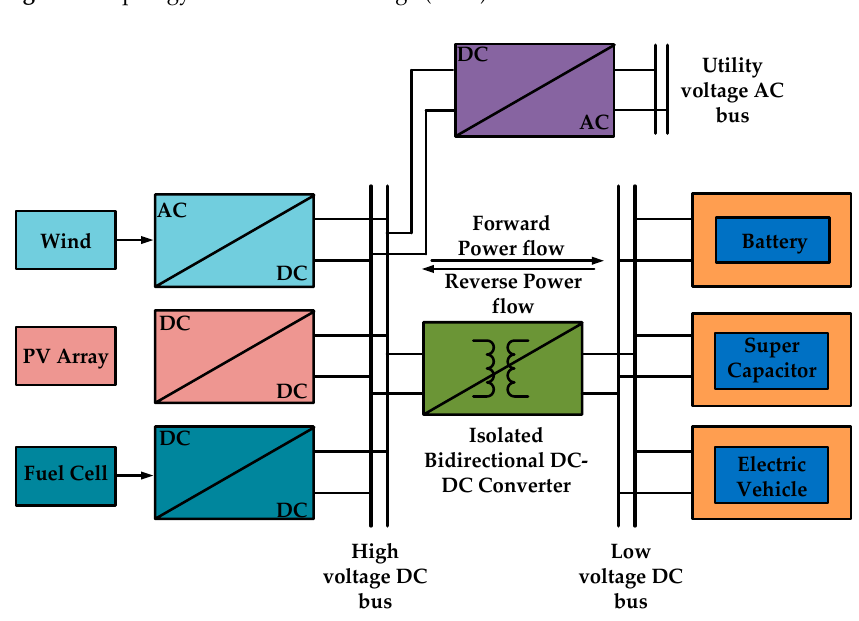
Figure 2. Microgrid with energy storage devices.